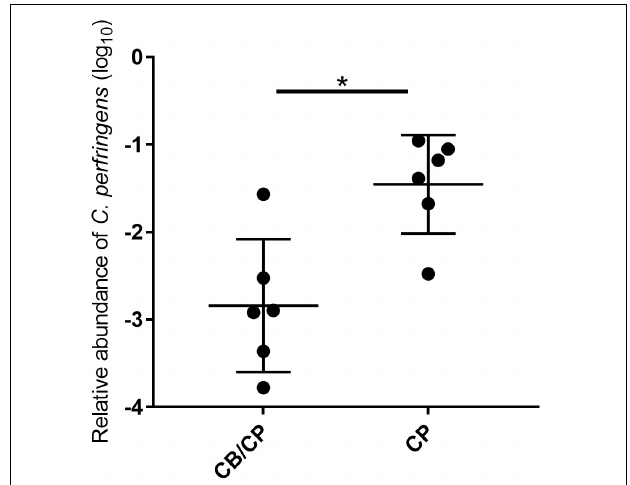
FIGURE 2 | Relative abundance of C. perfringens in the jejunum-ileum lumen post 1-day challenge. All chickens tested negative for C. perfringens until experimentally challenged, and the unchallenged groups tested negative for C. perfringens throughout the study. ∗ p < 0.05, measured using ANOVA; n =